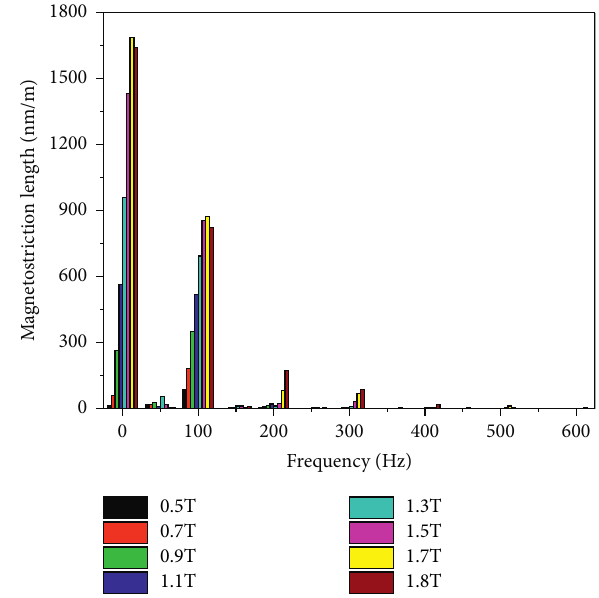
Figure 9: Magnetostrictive spectra at different magnetic flux